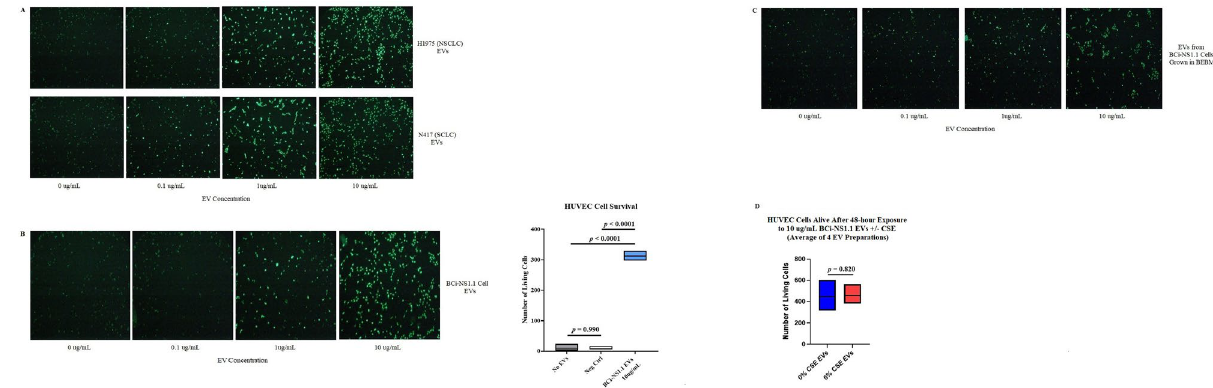
Figure 3. Human airway basal cell EVs promote the survival of HUVECs in culture. ( A ) , Images of HUVECs in single wells of a 384-well microtiter plate following 48-h incubation with different concentrations of EVs isolated from the H1975 non-small cell lung cancer and N417 small cell lung cancer cell lines. ( B ), Images of HUVECs in single wells of a 384-well microtiter plate following 48-h incubation with different concentrations of BCi-NS1.1 cell EVs. The live cells were counted under fluorescence microscopy, and the results of 3 replicate experiments using 10 µg/mL EVs is summarized in the floating bar graph to the right. The horizontal lines inside the floating bars represent the means of the 3 experiments. Neg Ctrl, negative control (an equal volume of a preparation from BEGM without BPE incubated for 48 h in flasks without cells and then processed by means of the same procedures used to isolate EVs). Adjusted P values correspond to differences between the bars on either end of the horizontal line below them and were calculated using Tukey’s multiple comparisons